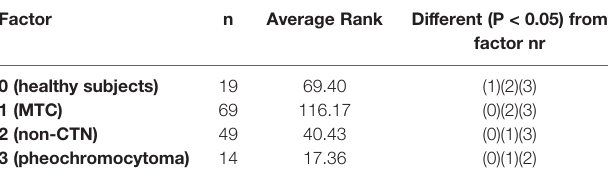
TABLE 2 | Post-hoc test after Kruskal-Wallis analysis for median circulating miR- 375 levels in the different groups: group 0: healthy subjects, group 1: MTC patients, group 2: patients with thyroid non-C-cell nodular diseases (non-CTN), group 3: pheochromocytoma patients.